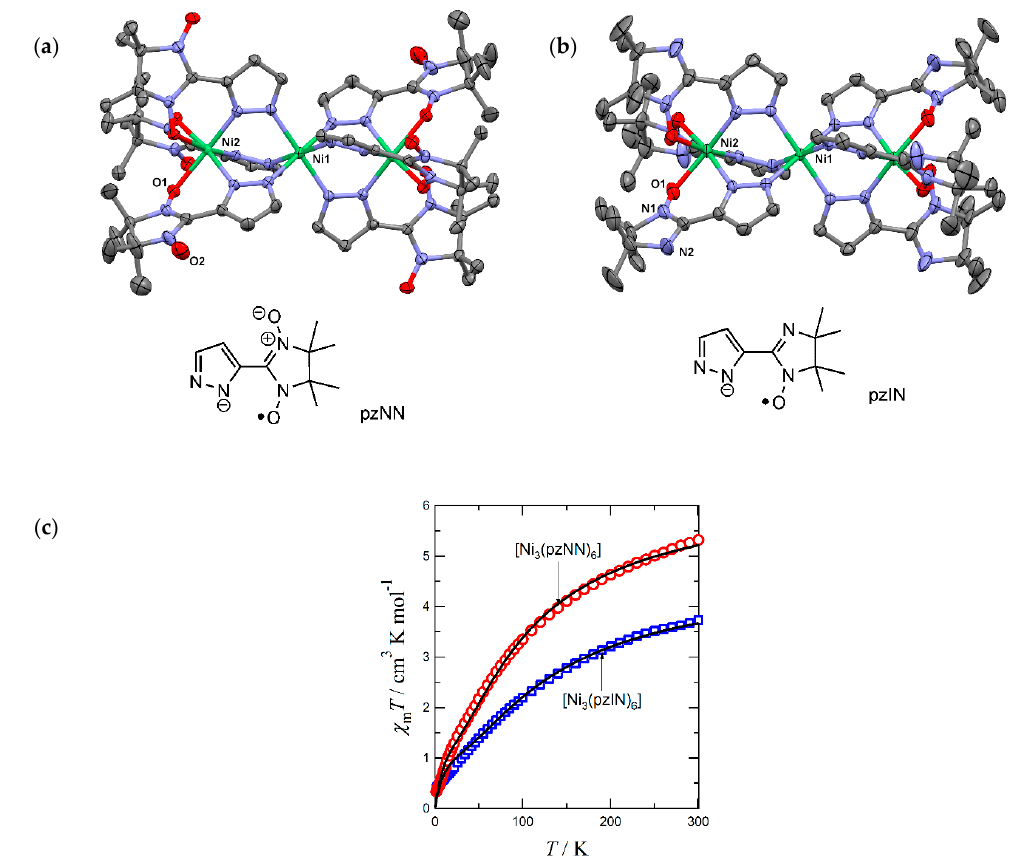
Figure 14. Molecular structures of ( a ) [Ni 3 (pzNN) 6 ] and ( b ) [Ni 3 (pzIN) 6 ] ( Pa 3 phase) with thermal ellipsoids at the 50% probability level. Solvent molecules and hydrogen atoms are omitted. Selected atomic numberings are indicated. The structural formulas of paramagnetic ligands are also shown. ( c ) Temperature dependence of χ m T for the two compounds. The solid lines represent calculated curves. Adapted with permission from [143], published by the Royal Society of Chemistry, 2006.